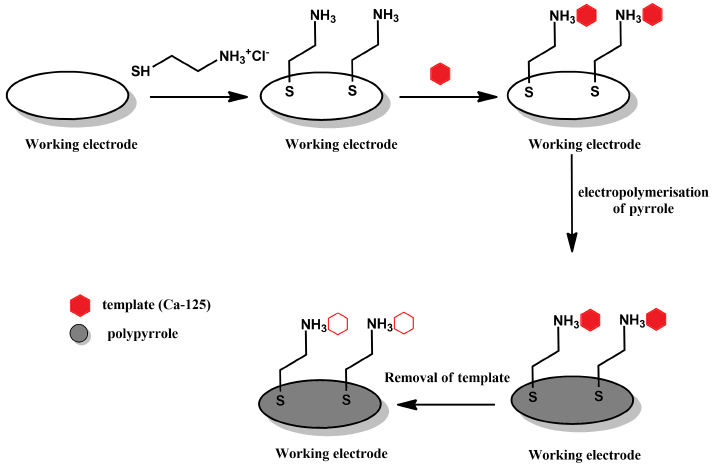
Figure 4. Schematic depiction of the stages comprising the polymerisation on template-modified electrodes